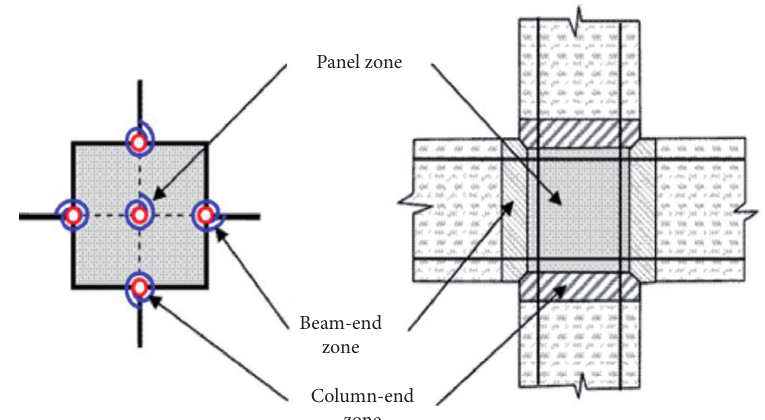
Figure 4: Schematic diagram of joint2D [8].